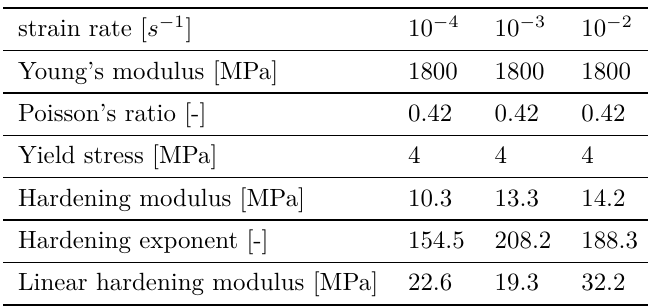
Table 1. Reverse engineered elastic-plastic material parameters for low-speed strain rates.